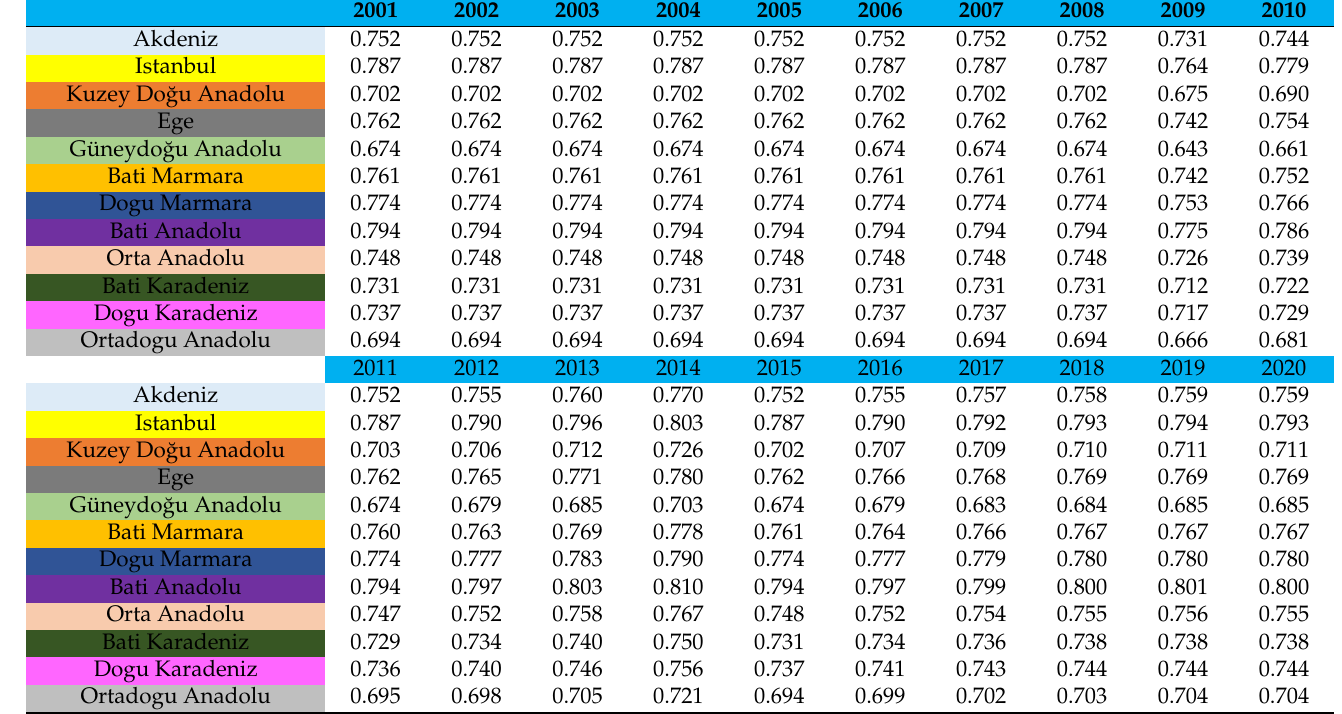
Table 15. Estimated literacy index—Turkey 2001–2020.